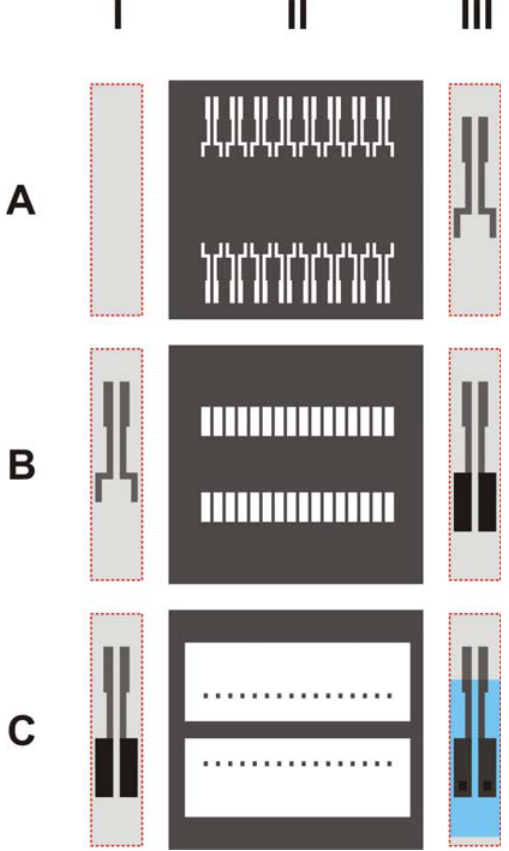
Figure 3. Schematic view of the patterns (II) used for ion-selective electrodes by screen-printing process. (A) stencil’s pattern used for fabrication of electrical contact of sensors, (B) stencil’s pattern used for fabrication of chemical membrane of screen-printed electrodes, (C) stencil’s pattern used for insulation layer fabrication. I and III are the schematic view of the substrate before and after the printing process.